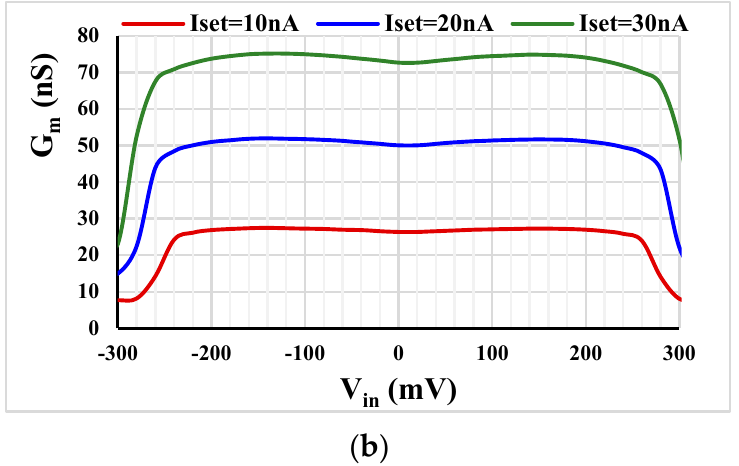
Figure 5. The MI-OTA output current ( a ) and the transconductance ( b ) versus the input voltage with various I set .